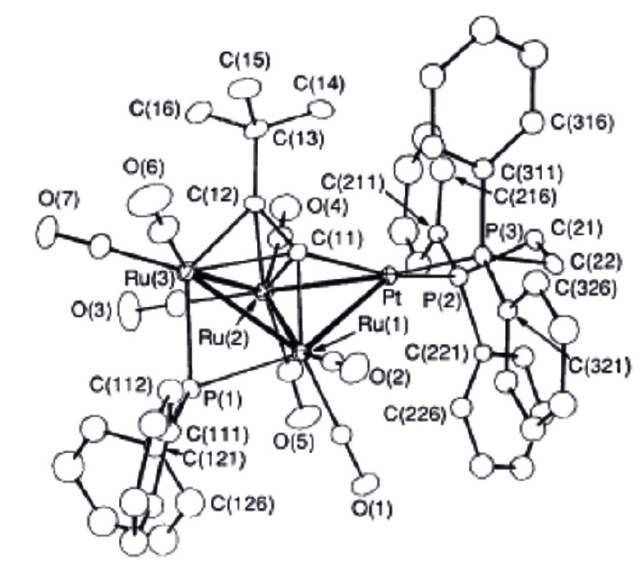
Figure 10. Structure of [( η 2 -dppe)Pt(µ